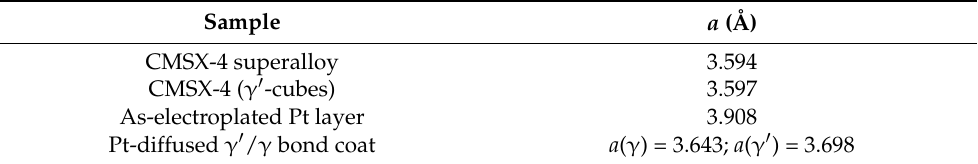
Table 3. Lattice parameters a (Å) calculated from XRD patterns.